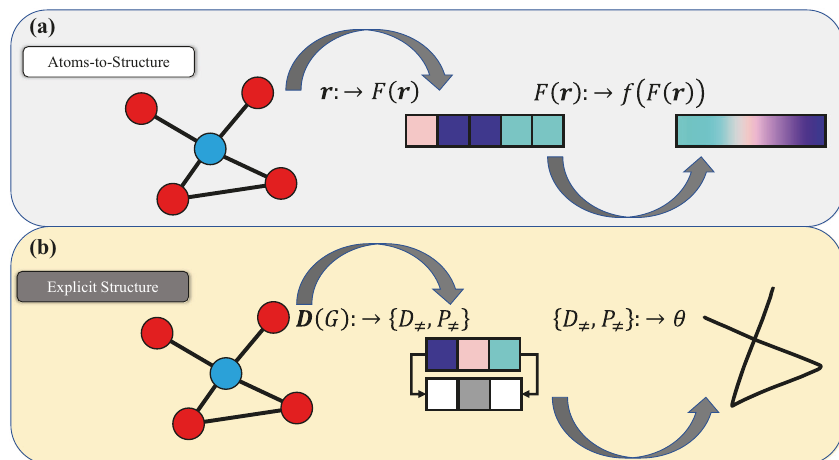
Fig. 1 Visual depiction of two structure-level characterization methods. a Atomic local neighborhoods are converted to feature vectors, which are modi fi ed statistically (usually taken as the N th moment) to construct a fi nal con fi guration descriptor that represents the entire structure. r : → F( r ) represents the mapping from atomic positions to atomic descriptors. F( r ): → f(F( r )) represents the mapping from atomic descriptors into a single structural descriptor through statistical modi fi cation of the atomic descriptors. b Our proposed methodology, in which global information about the atomic network is explicitly captured and passed through our order parameter to represent the structure of the network itself. The center portion of ( b ) represents the set of unique degrees captured within the graph placed above their corresponding probabilities of occurrence within the network. D(G): → {D ≠ , P ≠ } represents the mapping of the set of all degrees in G to the set of unique degrees in G, along with their corresponding probabilities. {D ≠ , P ≠ }: → θ represents the mapping of the set of unique degrees and corresponding probabilities in G to the structure-level order parameter of the